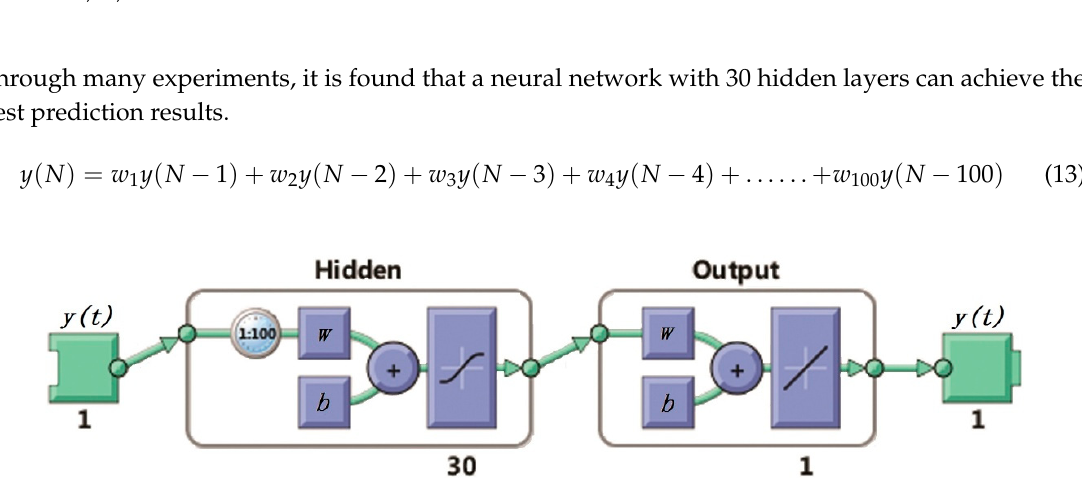
Figure 6. Nonlinear autoregressive neural network.